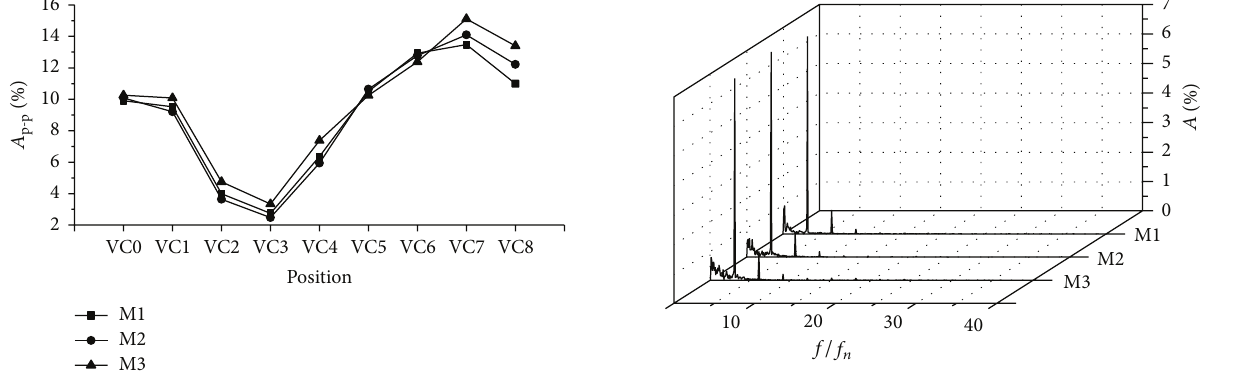
Figure 6: Peak-peak amplitudes at the points in the volute casing. Figure 7: Frequency spectrum of the pressure fluctuations at Point